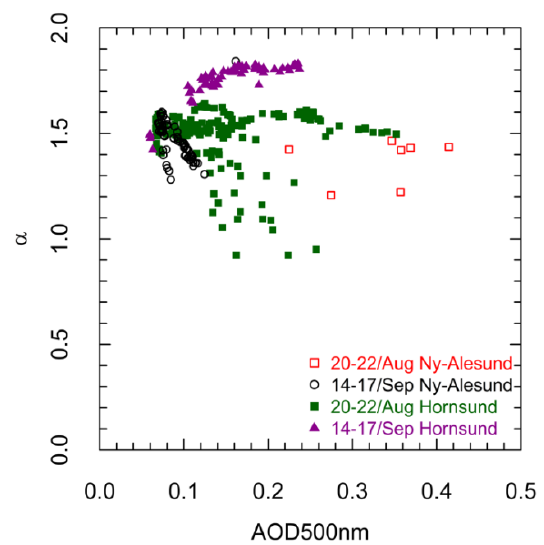
Figure 7. AOD time series retrievals from Hybrid Sky Scan inversions [94] during the summer 2017 biomass burning ( BB) events at two AERONET sites in Spitsbergen. ( a , b ) depict AOD values measured in August 2017 in Hornsund and Ny-Å lesund, respectively. ( c , d ) show AOD values measured in September 2017 in Hornsund and Ny-Å lesund, respectively.